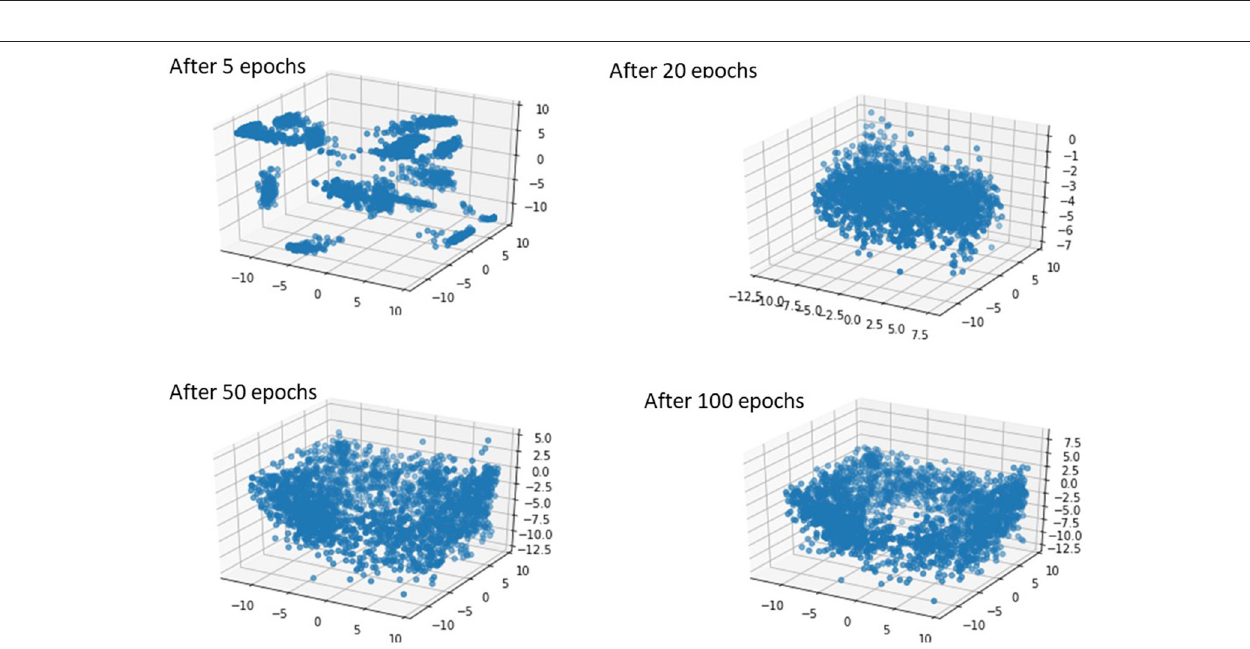
FIGURE 5 | The GAN model was able to produce MV geometries after several